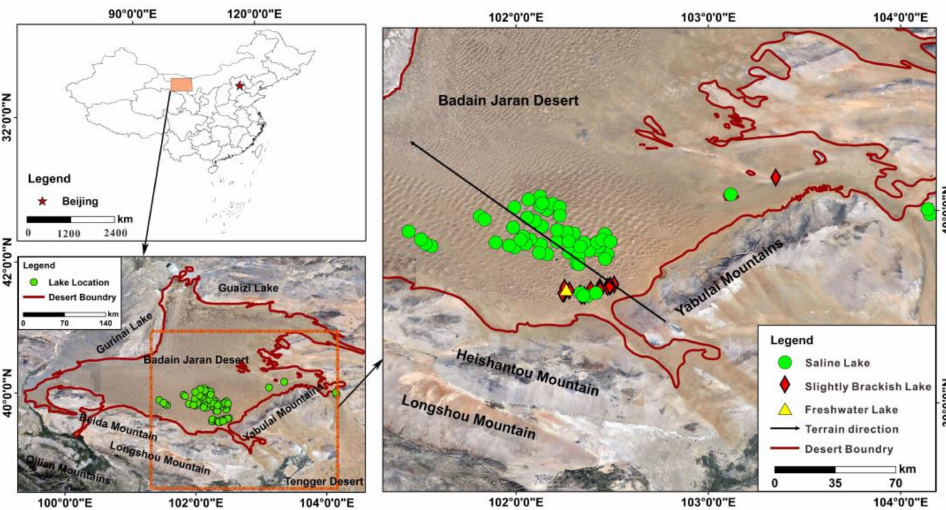
Figure 1. Map showing location of the study site and lake water samples, black line showing the terrain direction, and red lines showing the boundry of Badain Jaran Desert.The other portion indicates the sampling sites of the 80 sampled lakes in the desert with their locations highlighted as saline lake, slightly brackish lake and freshwater lake. The remote-sensing images were taken from Loca Space